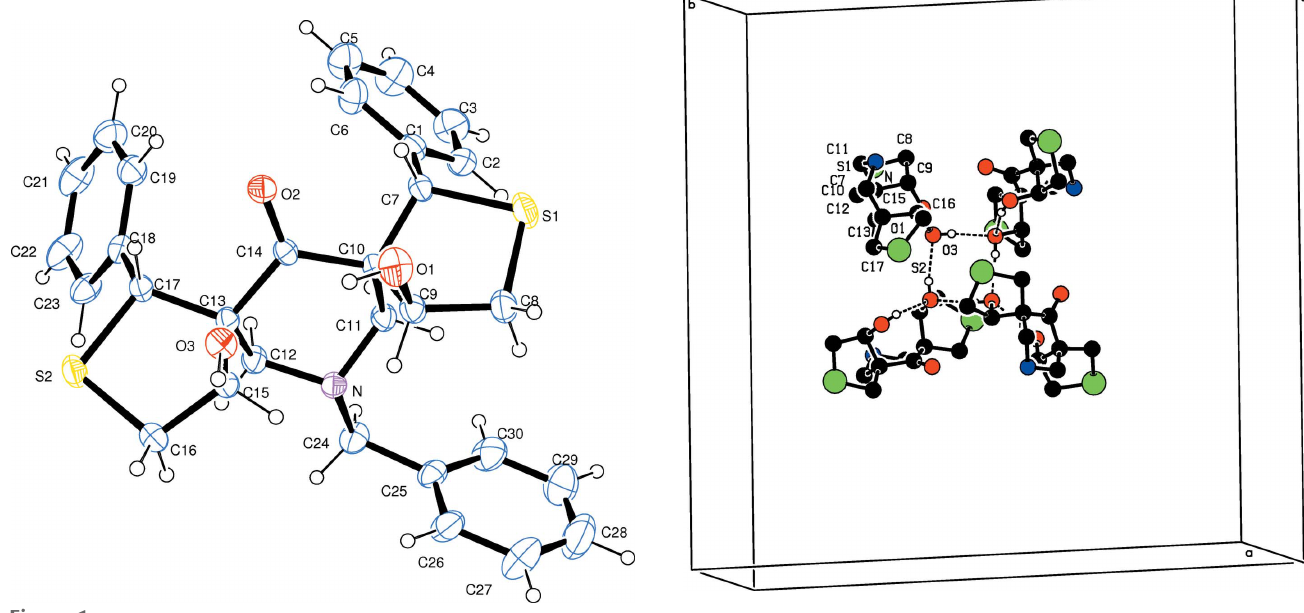
Figure 3 An O—H (cid:2)(cid:2)(cid:2) O interaction between atoms O3 and O1 of a symmetry- related molecule (at 1 (cid:5) x , (cid:5) 1 + y and 1 (cid:5) z ) leading to an R 4 motif.